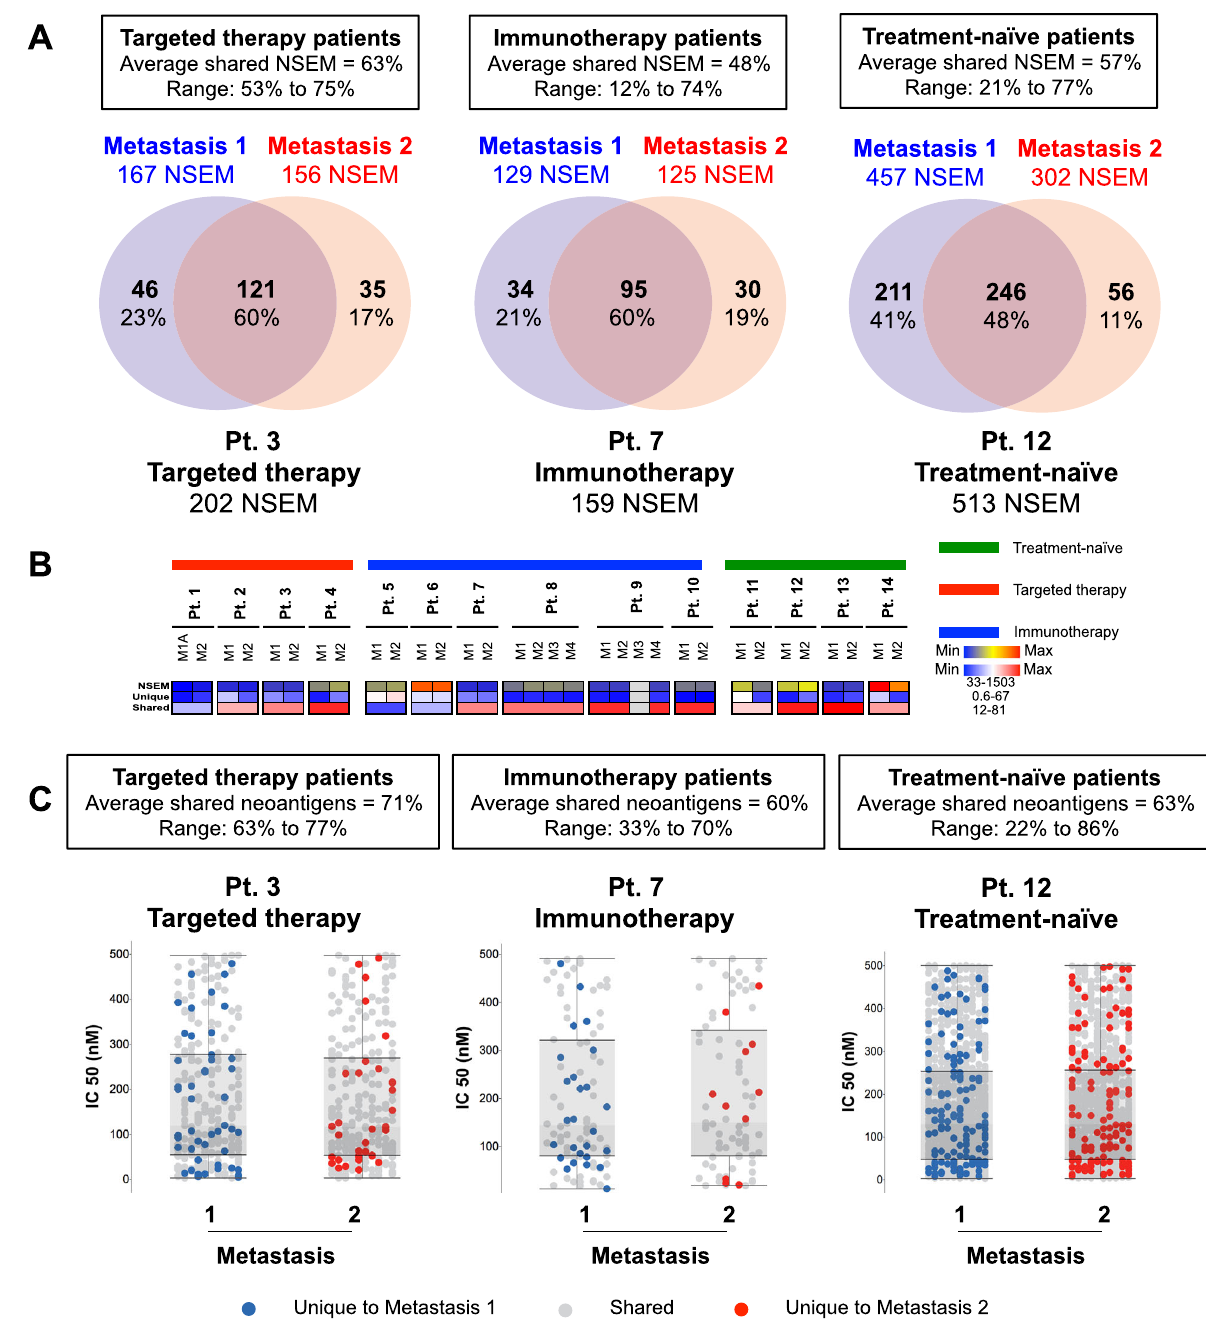
Fig. 2 Molecular heterogeneity in synchronous melanoma metastases. a Overall mutational analysis and overlap in targeted therapy, immune checkpoint blockade, and treatment-naïve patients and representative patients from each treatment background presented as percentage of shared ( purple ) and unique ( blue and red ) NSEM between synchronous metastases. b Aggregate genomic data showing number of somatic NSEM, percent unique and shared in targeted therapy, immune checkpoint blockade, and treatment-naïve patients. c Predicted neoantigens in a representative targeted therapy, immune checkpoint blockade, and treatment-naïve patients based on their respective IC50 values. Shown are neoantigens shared ( gray ) and unique ( blue or red ) in each metastasis within patients presenting an IC50 < 500